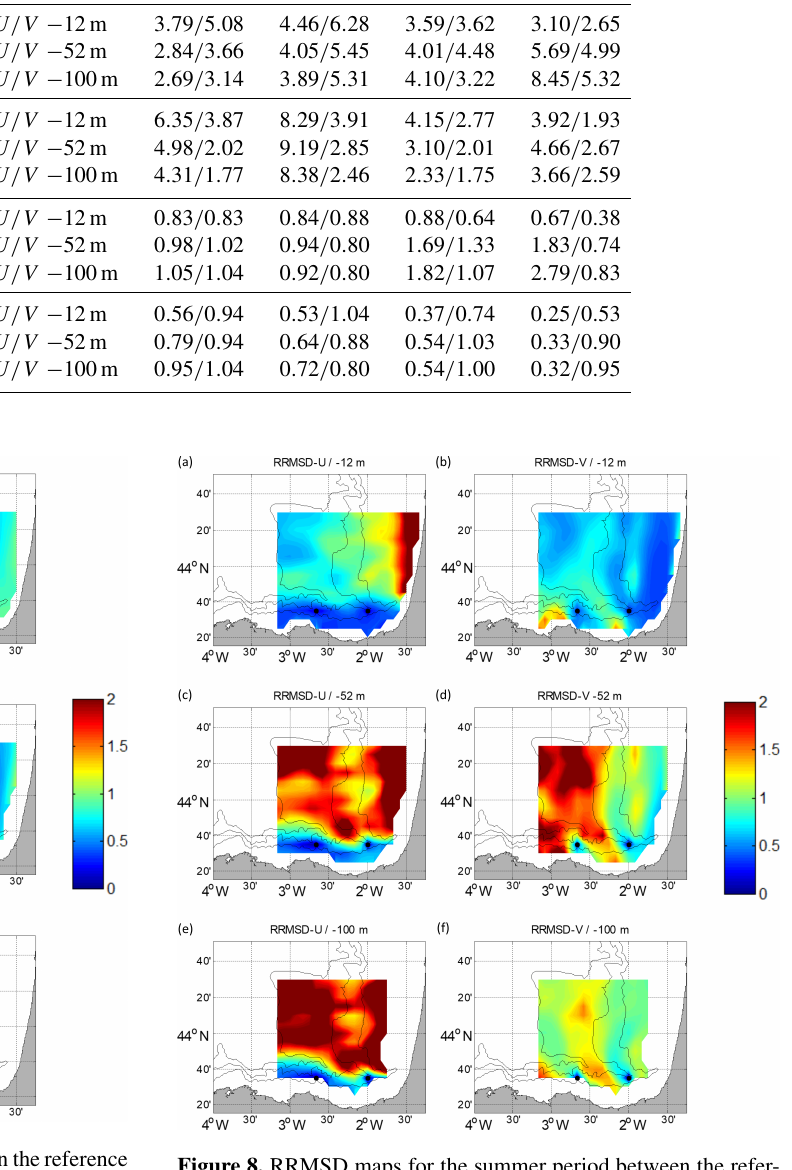
Figure 8. RRMSD maps for the summer period between the refer- ence fields and the outputs of the DCT-PLS for U (a, c, e) and V (b, d, f) . Different depths are considered: − 12m (a, b) , − 52m (c, d) and − 100m (e, f) . The black dots depict the locations of the current vertical